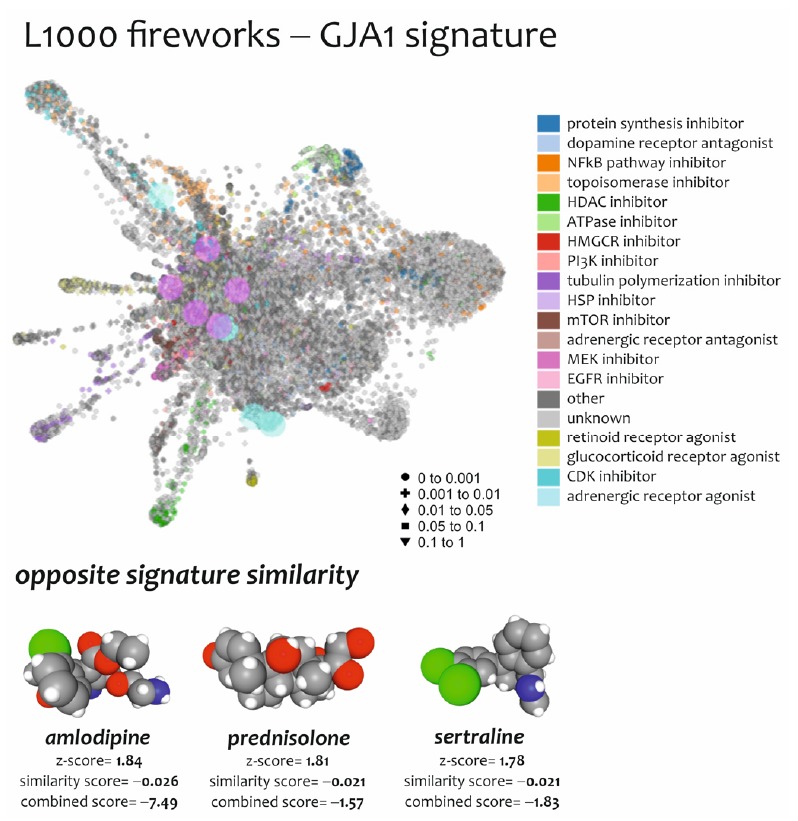
Figure 6. Anti-signature perturbation analysis. L1000FDW visualization of drug-induced signature. Input genes are represented by the significantly GSPC-GJA1 and GSNC-GJA1. Dots are color-coded based on the Mode of Action (MOA) of the respective drug. The drugs with a higher CS (i.e., amlodipine, sertraline, and prednisolone) were selected.